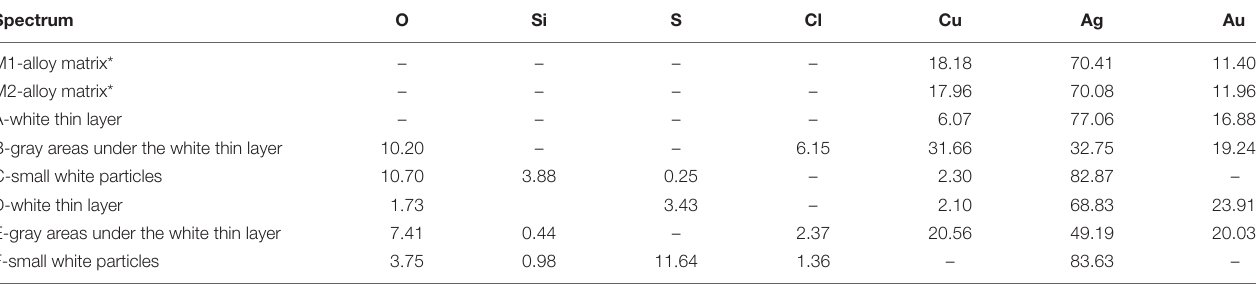
TABLE 1 | Energy-dispersive spectroscopy (EDS) elemental composition [expressed as weight percent (wt%)] of the different areas of the cross-sectioned fragment of the nariguera F4-03 from the tomb of the Lady of Cao.